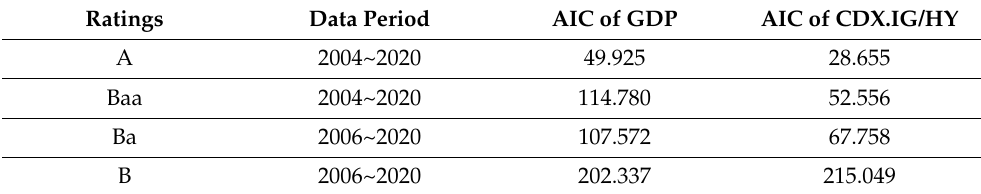
Table 6. AIC of Goodness-of-Fit: regression of DR on GDP and on CDX.IG/HY.